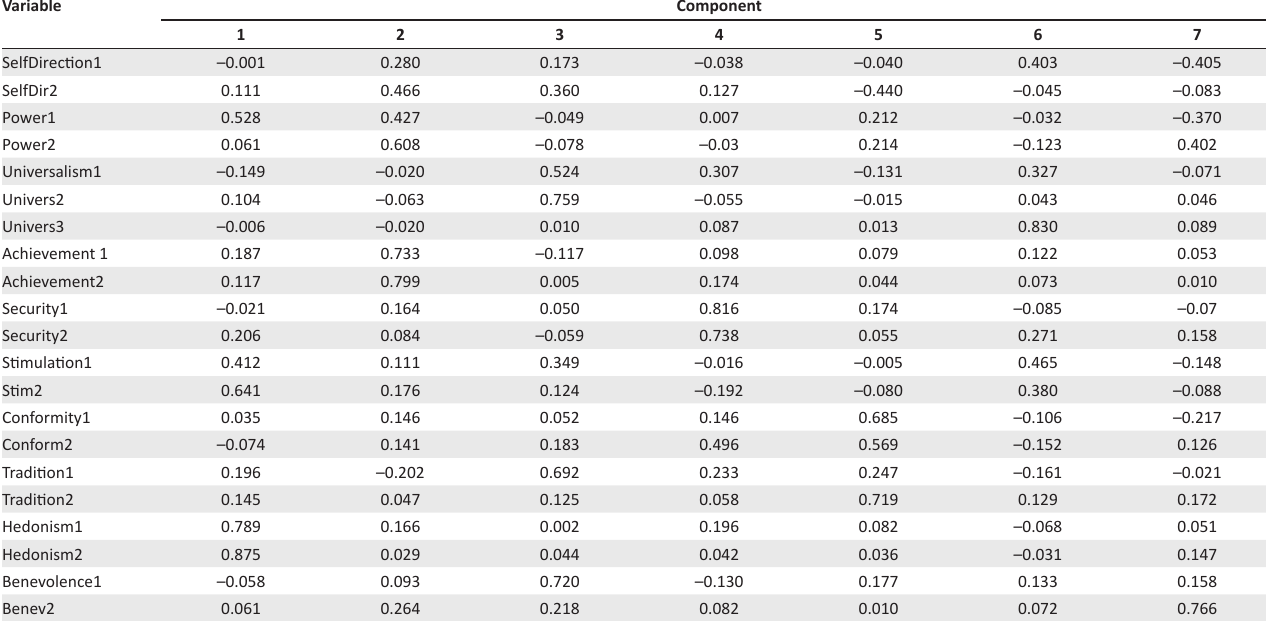
TABLE 3. Exploratory factor analysis component